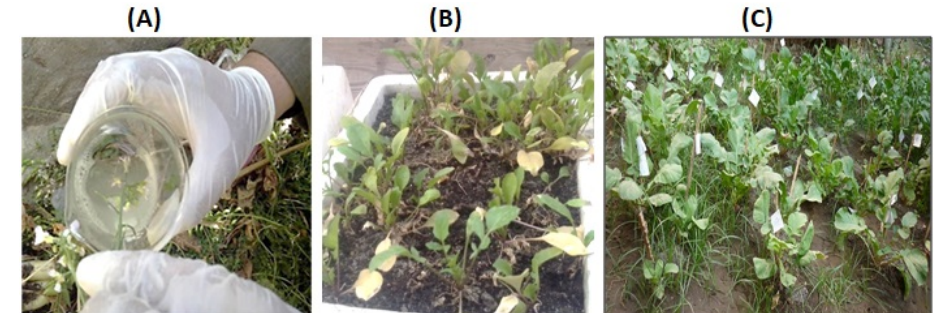
Figure 2. Representative photographs of Raphanus sativus L. plants. ( A ) Floral dip transformation of Raphanus sativus L. plants. ( B ) Selection of transgenic Raphanus sativus L. plants after spraying the foliar leaves with BASTA solution (phosphinothricin; 25 µg/mL) 6 times at 3 - day intervals. ( C ) T 1 plants of IFN- α 2a transgenic Raphanus Sativus L. plants grown in soil.